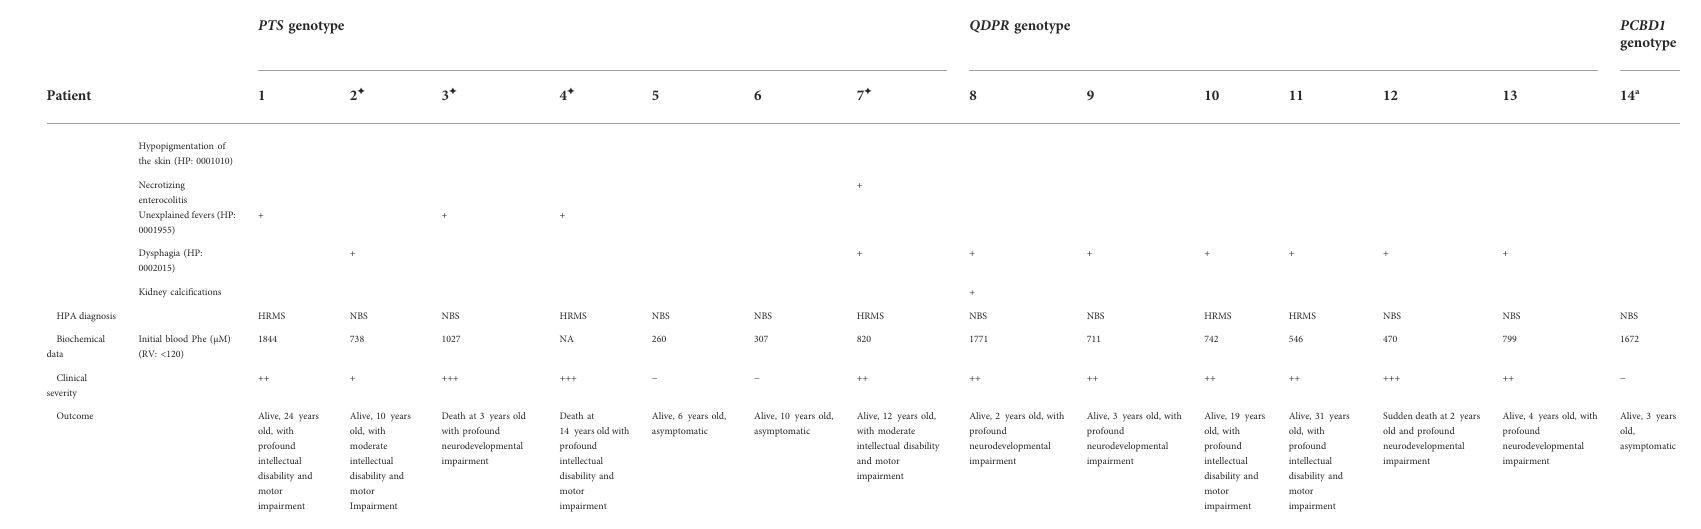
TABLE 4 ( Continued ) Genotype/phenotype description of Mexican patients bearing clinically relevant biallelic PTS , QDPR , and PCBD1